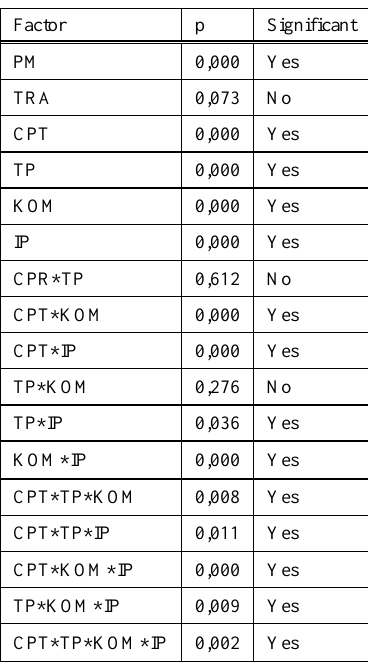
Table 4. MANOVA p values (α = 0.05 significant factors criteria